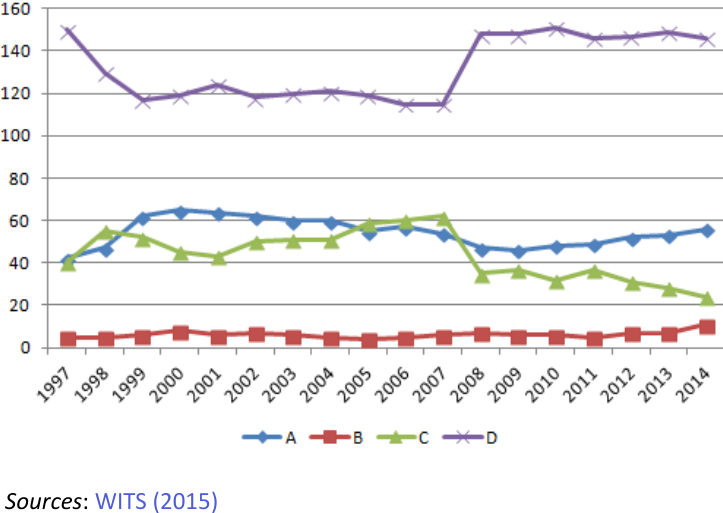
Figure 2: Trends in Number of Products Groups A, B, C and D of Indonesia, 1997-2014 Malaysia has positive trend for products A in the past five years, and flat trend for products B, negative trend for products C and positive trend in group D. It shows an increase in comparative advantage and exports specialization.